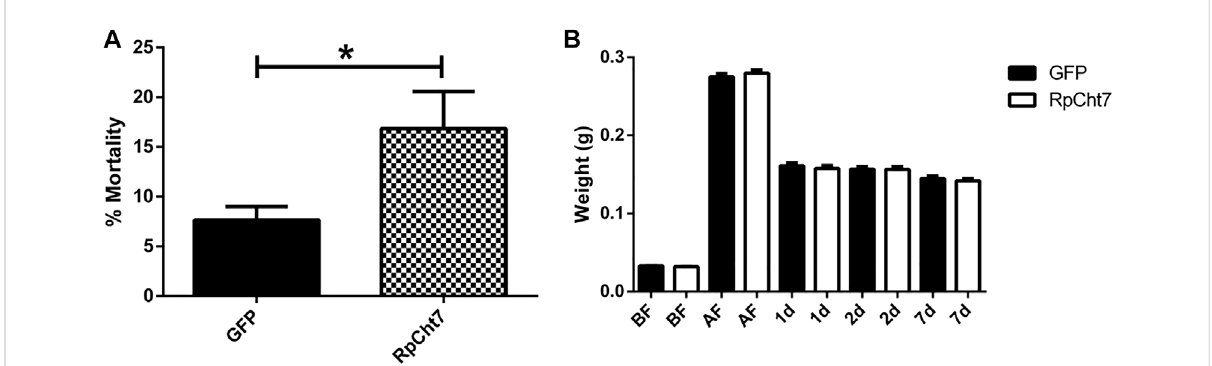
FIGURE 8 (A) Mortality in fi fth-instar nymphs of R. prolixus . Percentage of dead insects 2 weeks after injection with ds GFP or ds RpCht7 . The experiment wasperformedsixtimes,independentlywith20 – 30insectseachtime(biologicalreplicas, n =6),* p < 0.001(T-test). (B) Weightof fi fth-instarnymphs of R. prolixus . BF, Before feeding; AF, After feeding, 1, 2, and 7 days after feeding. ds GFP : Black columns; ds RpCht7 : White columns. N = 9. No signi fi cant differences were observed between ds RpCht7 and ds GFP groups ( p > 0.05; one-way ANOVA –